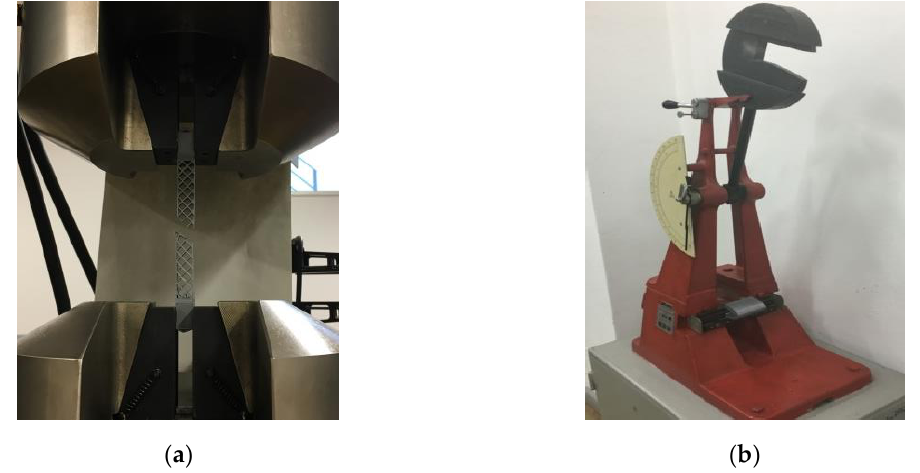
Figure 4. The mechanical tests of the sandwich specimens: ( a ) tensile testing of diamond-celled core sandwich structures; ( b ) charpy impact device.